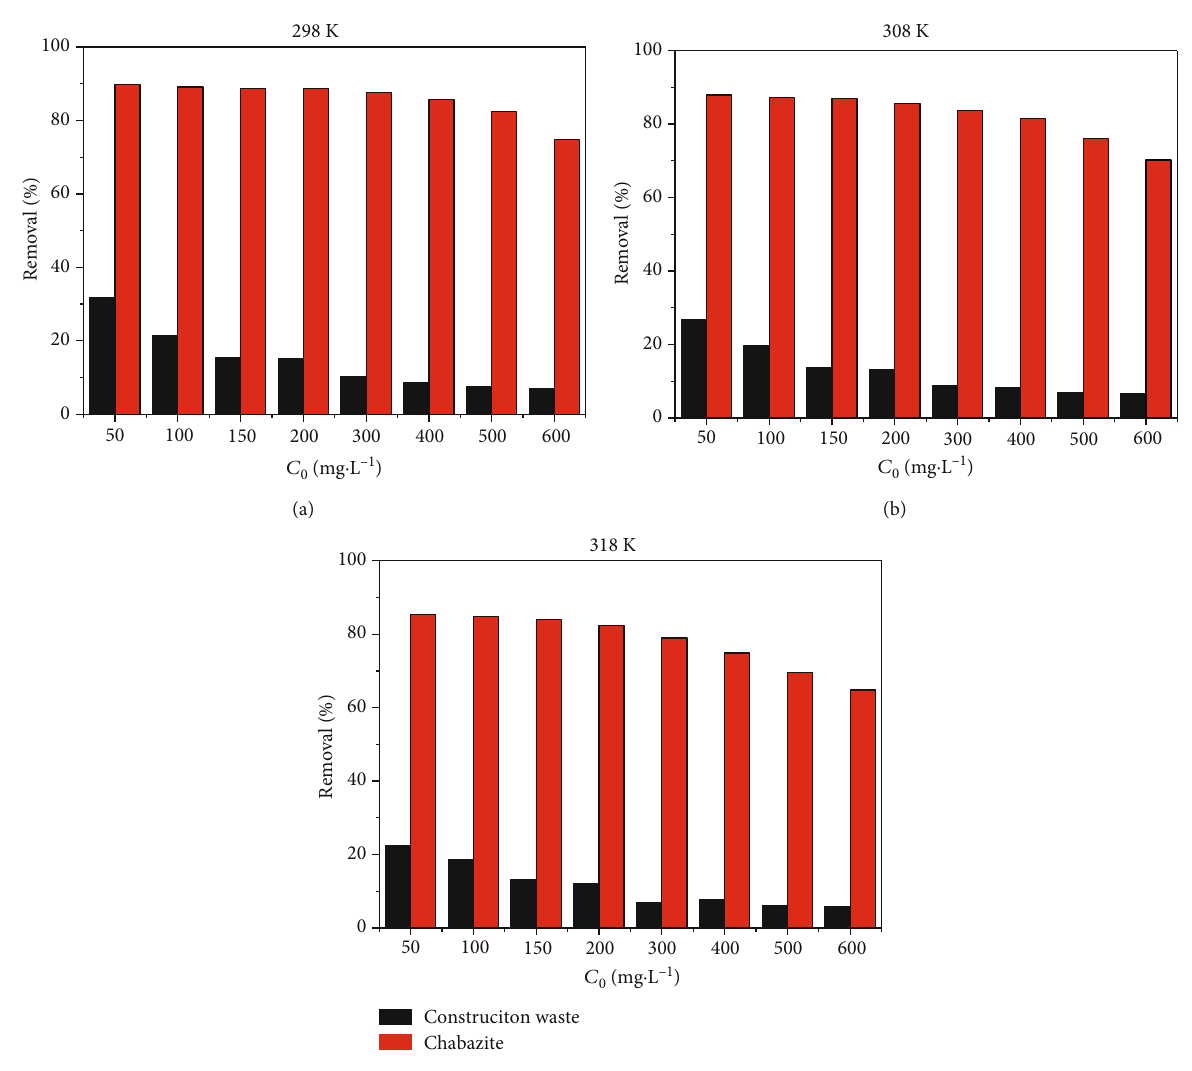
Figure 7: Removal of MB on construction waste and chabazite at di ff erent